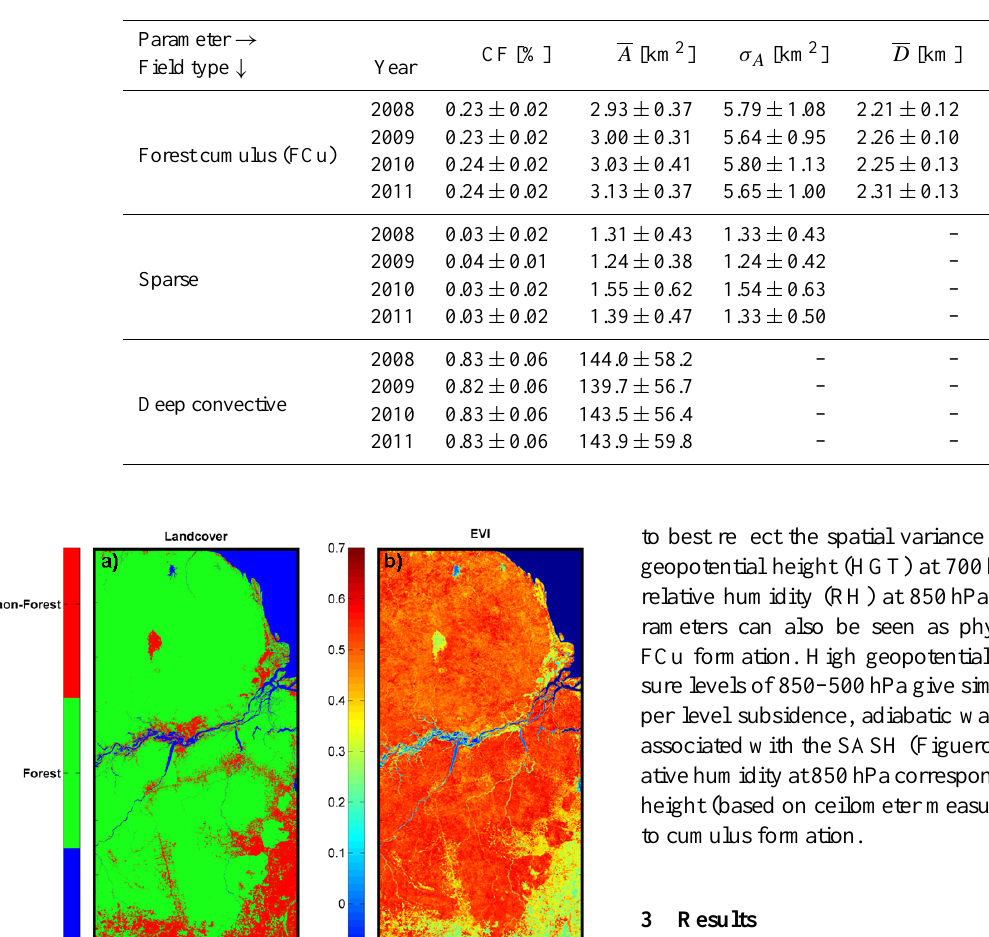
Table 2. Average statistics for the cloud fields (and their spatial parameters) as defined in Table 1, years 2008–2011. Missing data represent irrelevant statistics (for example, distance between clouds is meaningless for sparse and deep convective fields since we commonly observe only one cloud within the 25km moving window).